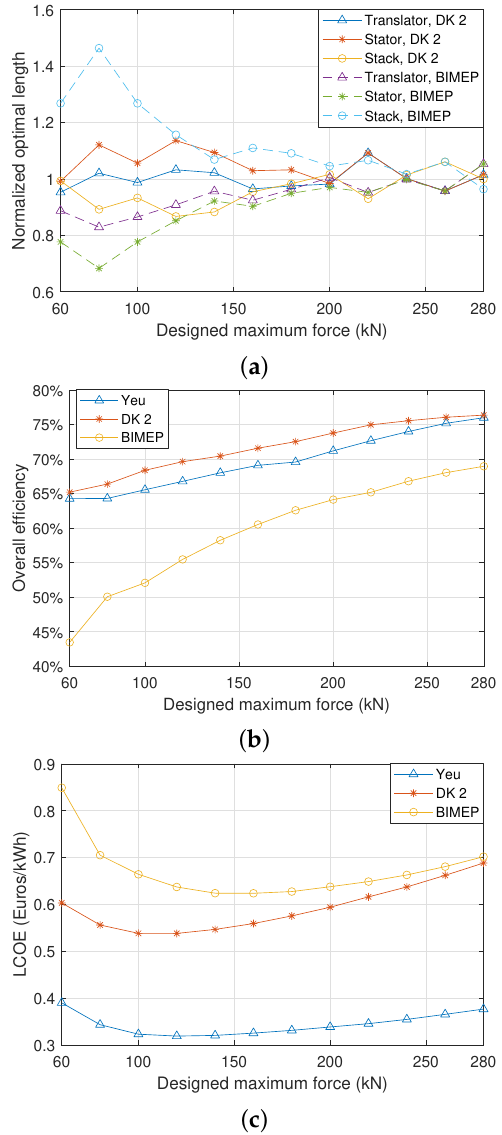
Figure 11. The optimized design parameters, the overall efficiency and the LCOE of the WEC with various designed maximum forces in three different wave sites. ( a ) The optimized design parameters for DK 2 and BIMEP, which are normalized to the corresponding values in Yeu island. ( b ) The overall efficiency of the linear generator as a function of the designed maximum generator force. ( c ) The LCOE of the WEC as a function of the designed maximum generator